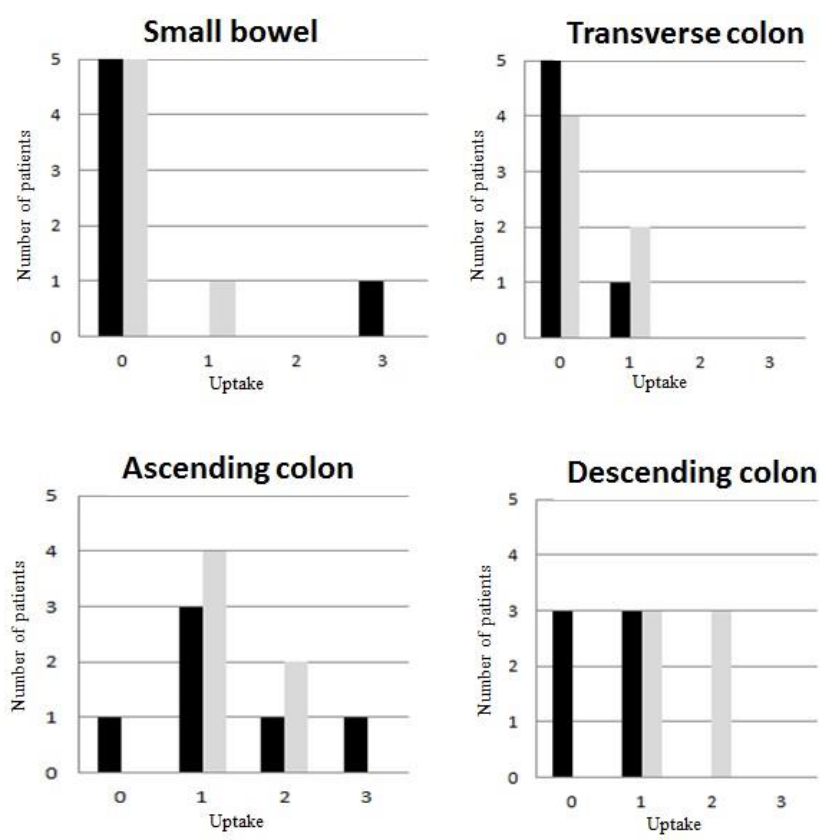
Figure 1. Comparison of white blood cells (WBC) and 99mTc-HIG scores in the small bowel, ascending, transverse, and descending colon. X axis: uptake of WBCs (black bars) and 99mTc-HIG (grey bars) by a 4-point scale (0 = no uptake; 1 = faint uptake; 2 = intermediate uptake; 3 = strong uptake). Y axis: number of patients. Patient 7 is not included.